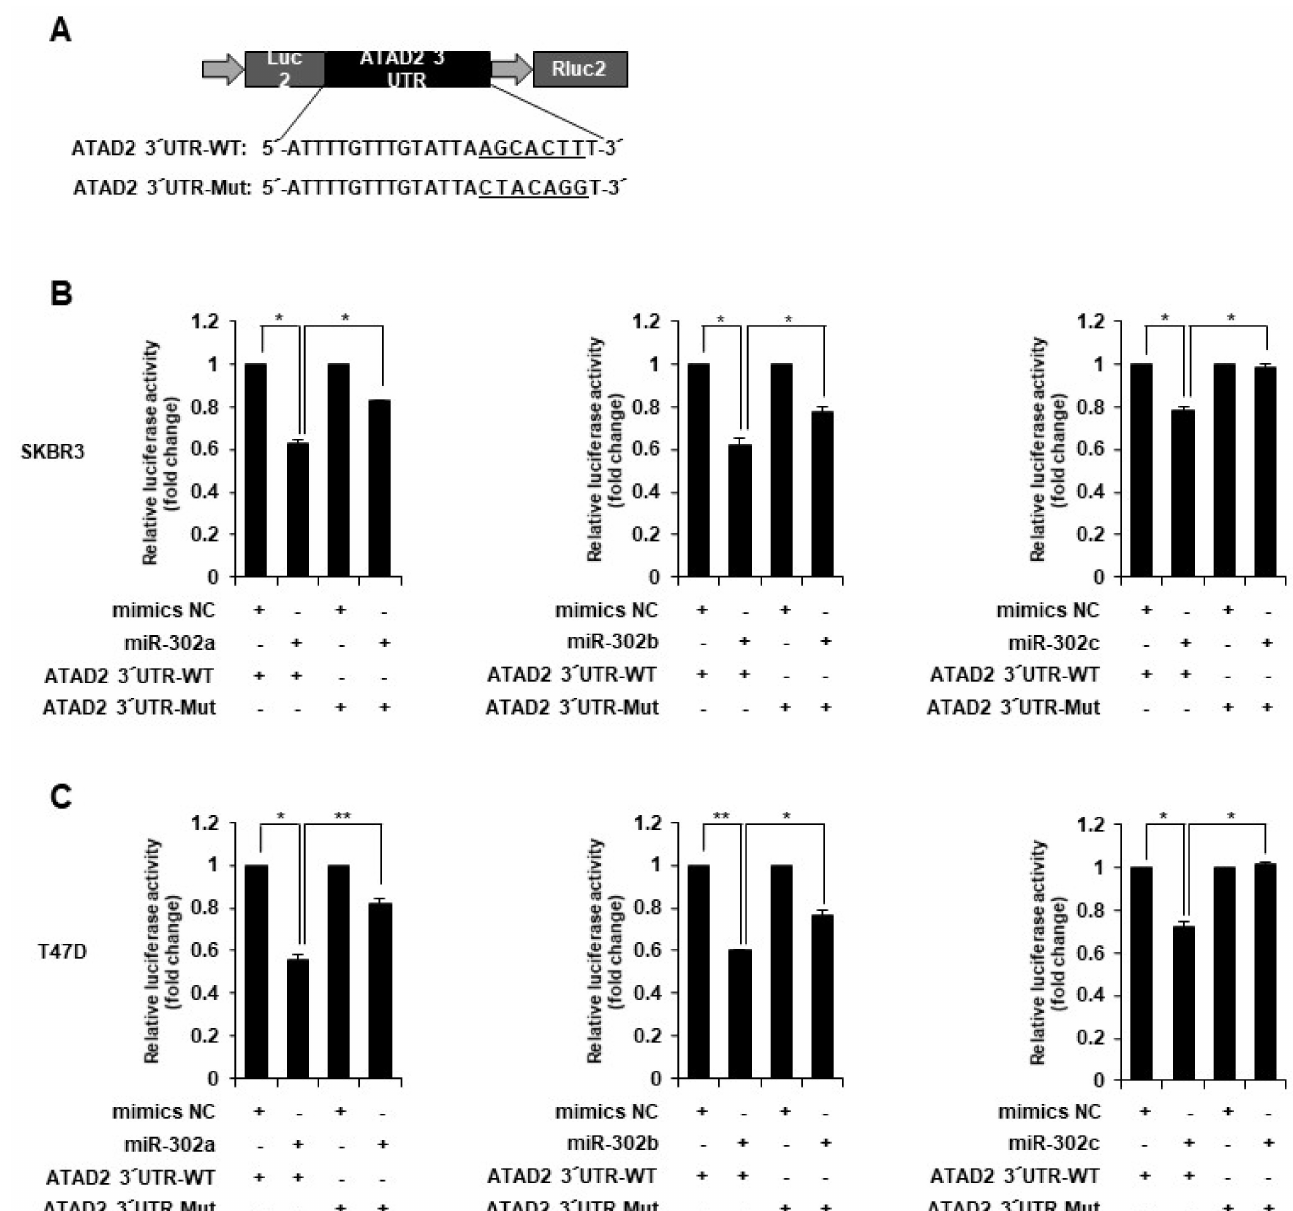
Figure 4. miR-302 family targets 3 (cid:48) -UTR of ATAD2 mRNA. ( A ) Schematic diagram of the luciferase reporter vectors containing the predicted miR-302 family binding sites of 3 (cid:48) -UTR of ATAD2 mRNA. WT or mutant sequences of 3 (cid:48) -UTR of ATAD2 mRNA were cloned into downstream region of the Firefly luciferase reporter gene. ( B , C ) WT or mutant luciferase reporter vectors were co-transfected with negative control (NC) or miR-302 family (a, b, and c) into ( B ) SKBR3 or ( C ) T47D cells. Luciferase activity was measured after 24 h transfection as described in Materials and Methods. Graphs represent relative fold-changes compared to control and show the mean of three independent